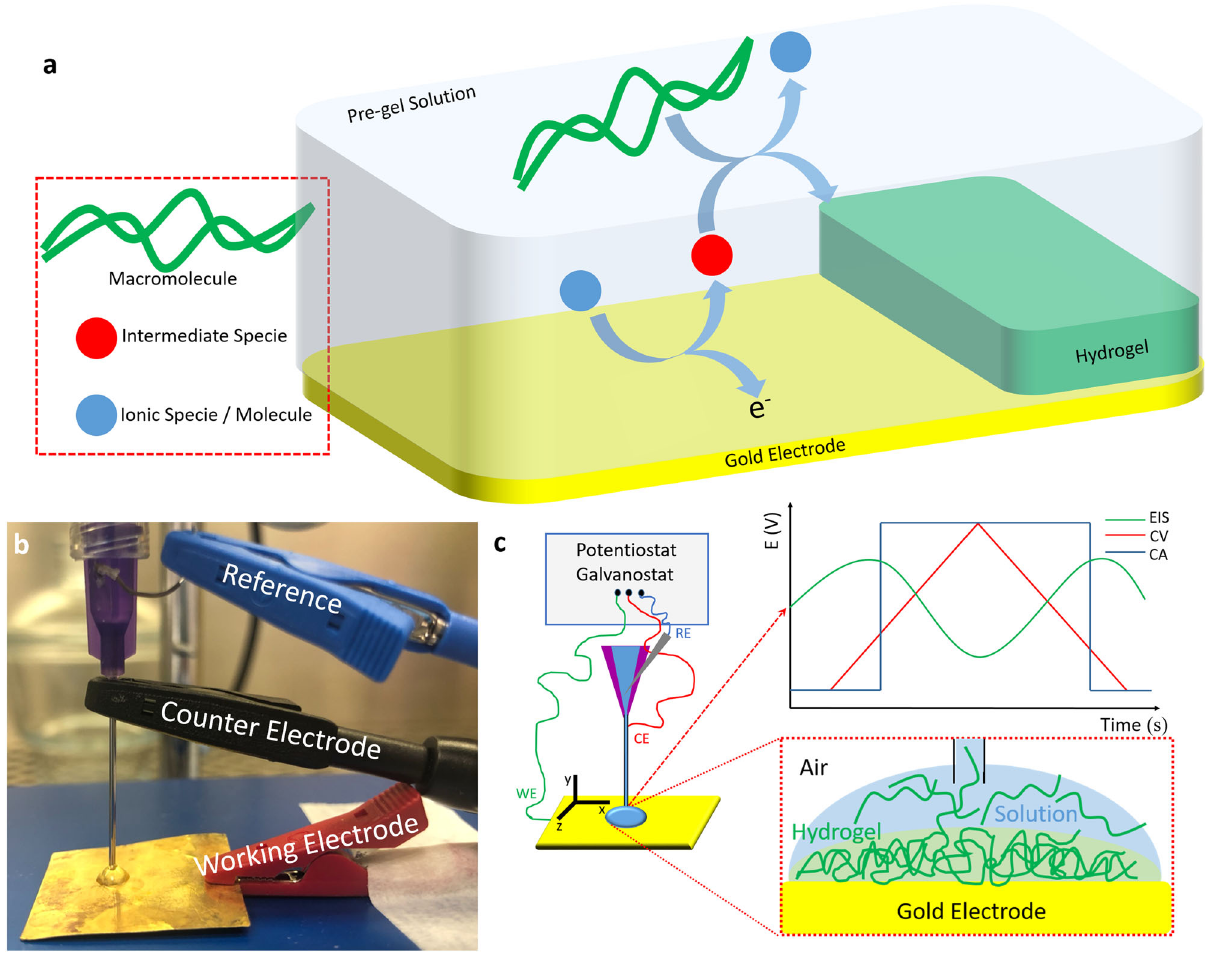
Fig. 1 Electro-assisted hydrogel deposition and con fi guration of the electrochemical/3D-printing setup. a Schematic representation of the general mechanism of electro-assisted hydrogel deposition over a conductive surface. An ionic species or molecule (blue sphere) is oxidised over the electrode (losing electrons), generating an intermediate species (red sphere) that reacts with the macromolecule (either chitosan or alginate, green) leading to crosslinking and deposition of the hydrogel. b Photograph of the 3-electrodes con fi guration with WE connected to a gold plate, needle of the customised nozzle connected as CE and Ag/AgCl pseudoreference wire connected as RE. c Schematic representation of the 3-electrodes con fi guration connected to a potentiostat/galvanostat enabling deposition and electrochemical measurements in situ. Insets: (above) example of electrochemical experiments (electrochemical impedance spectroscopy, EIS, green; cyclic voltammetry, CV, red and chronoamperometry, CA, blue), (below) schematic representation of hydrogel formation in a